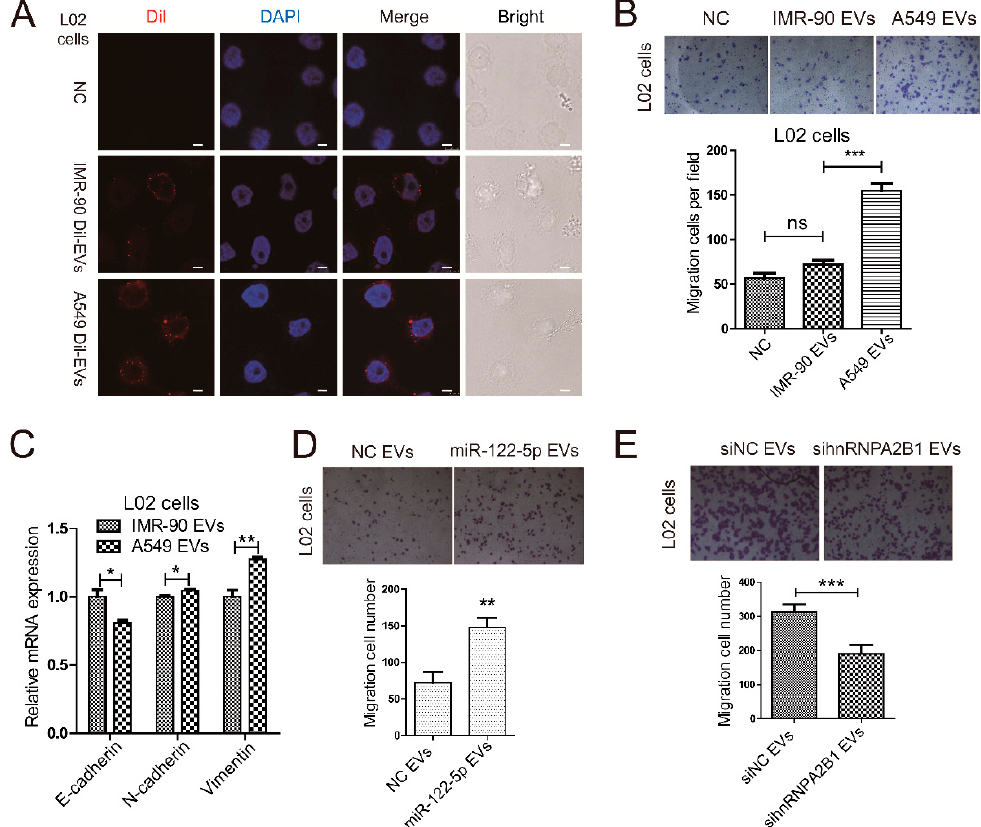
Figure 5. hnRNPA2B1 promotes the migration of L02 cells through regulating the selective secretion of miR-122-5p into A549 EVs. ( A ) Confocal microscopy of L02 cells incubated for 48 h with Dil-labeled IMR-90/A549 EVs (red). The white solid lines represent 5 µ m scale bars. ( B ) Representative photographs (100 × ) of Transwell assay indicated migration of L02 cells treated with EVs from IMR-90 or A549 cells cultured medium. In addition, the statistical results of migrated cells were shown as the down panel. ( C ) qRT-PCR results showed the mRNA expression levels of E-cadherin, N-cadherin and Vimentin in IMR-90 and A549 cells. In addition, the statistical results of migrated cells were shown as the right panel. ( D ) Representative photographs (100 × ) of Transwell assay showed migration of L02 cells treated with EVs from A549 cells pre-transfected with miR-122-5p mimic or NC mimic. In addition, the statistical results of migrated cells were shown as the down panel. ( E ) Representative photographs (100 × ) of Transwell assay showed migration of L02 cells treated with EVs from A549 cells pre-transfected with hnRNPA2B1 siRNA or NC siRNA. In addition, the statistical results of migrated cells were shown as the down panel. Three independent experiments were performed, and the statistical analyses were performed with the Student’s t test. Ns: no significance, *: p < 0.05, **: p < 0.01, ***: p <